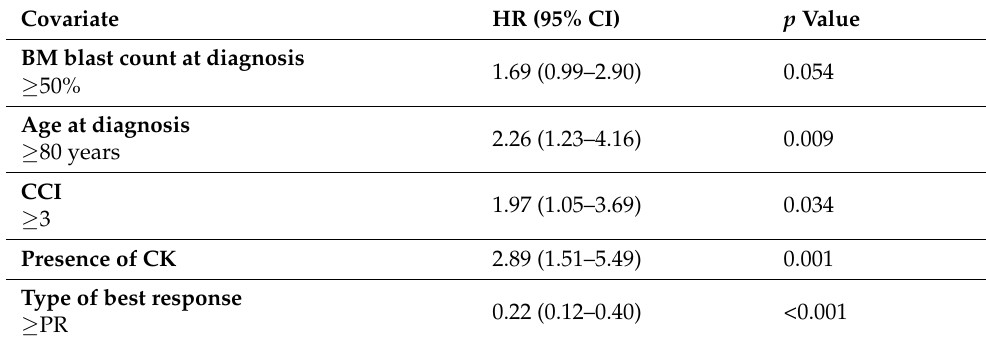
Table 3. Multivariate analysis for overall survival (Cox proportional hazards regression